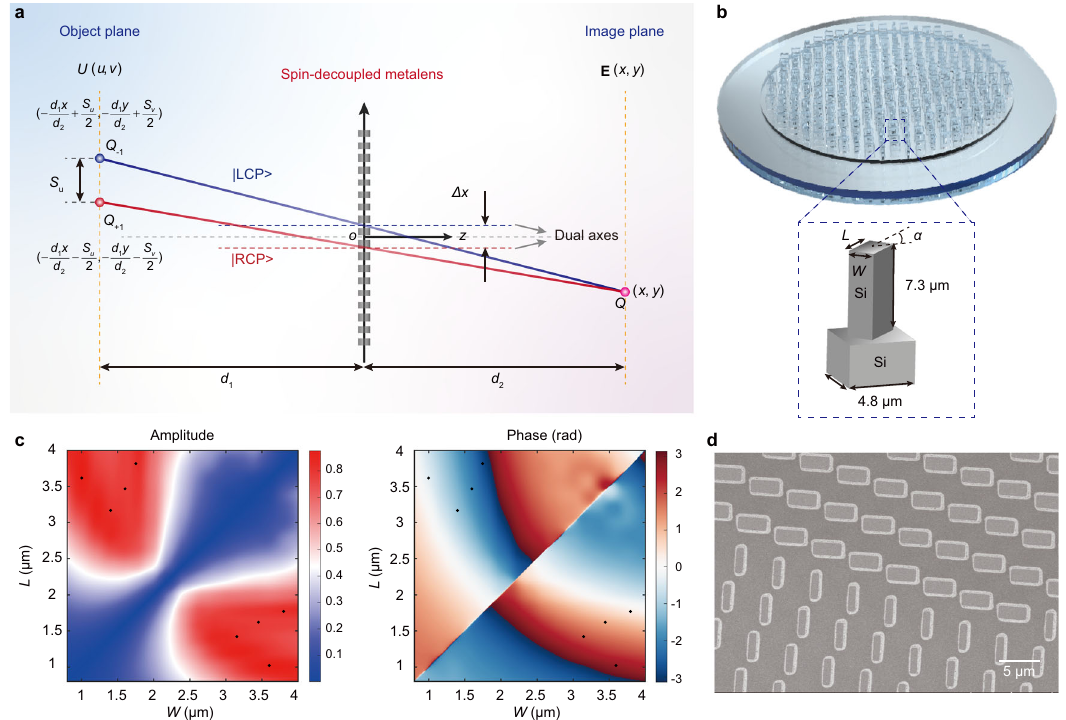
c Polarization conversion amplitude and the phase shift as functions of W and L . The black dots represent the selected eight unit cells with high conversion ef fi - ciency and equal phase step. d Scanning electron microscope (SEM) images of the metalens consisting of all-silicon nanopillars with different geometries and